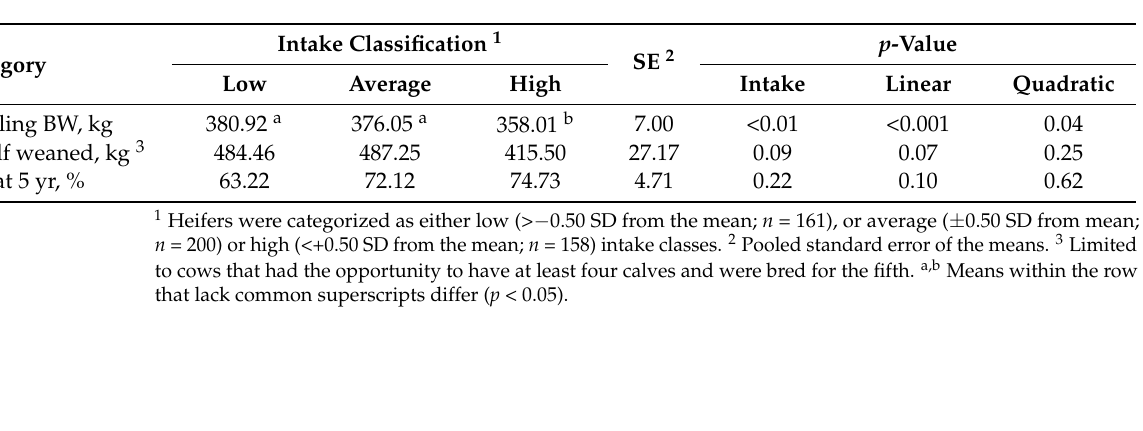
Table 2. The influence of heifer post-weaning intake expressed as grams per kg of body weight on subsequent heifer yearling weight, total lbs. of calf weaned and cow longevity spanning 5-breeding seasons and 4 weaned calf